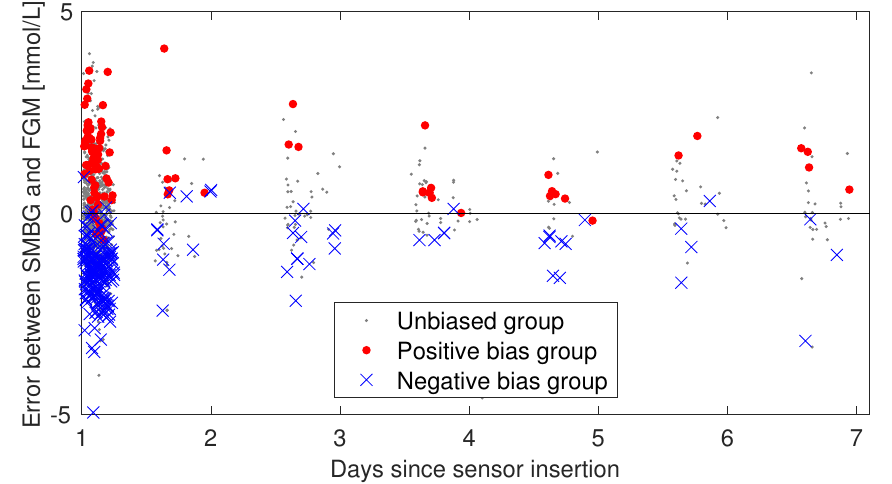
Figure 6. Persistence of bias in days 2–7. The individual sensor errors (SMBG–FGM) are plotted against time and colored according to what bias group the participant was in at day 1. If the bias observed in day 1 is not persistent, one would expect the blue and red data points to start mixing as time progresses. The day 1 session is included in this plot, but the analysis of bias persistence considered data from days 2–7 separately from day 1